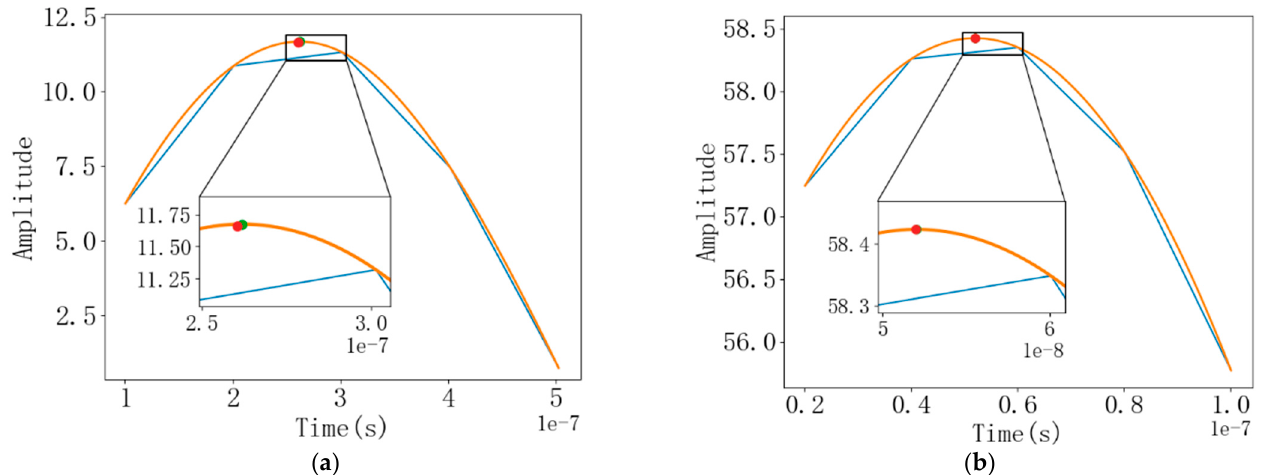
Figure 10. ( a ) When the sampling rate is 10 times the signal frequency, the comparison between the original function and the interpolation function; ( b ) When the sampling rate is 50 times the signal frequency, the comparison between the original function and the interpolation function. Table 1. Comparison of different interpolation fitting